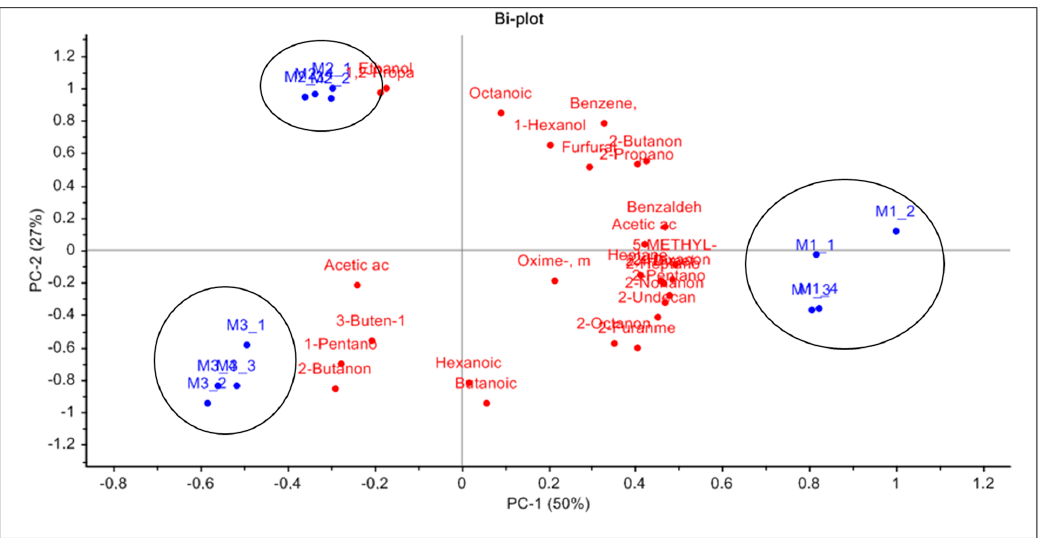
Figure 1. Principal Component Analysis (PCA) biplot of the 3 different commercial samples of mascarpone (M1, M2, and M3). For each sample, the mean (n = 4) is represented by the sample name. Score plot was given by the Volatile Organic Compound (VOC) content for each sample and loading plot of the single volatile organic compounds. The codes correspond to the samples indicated in Table 1.